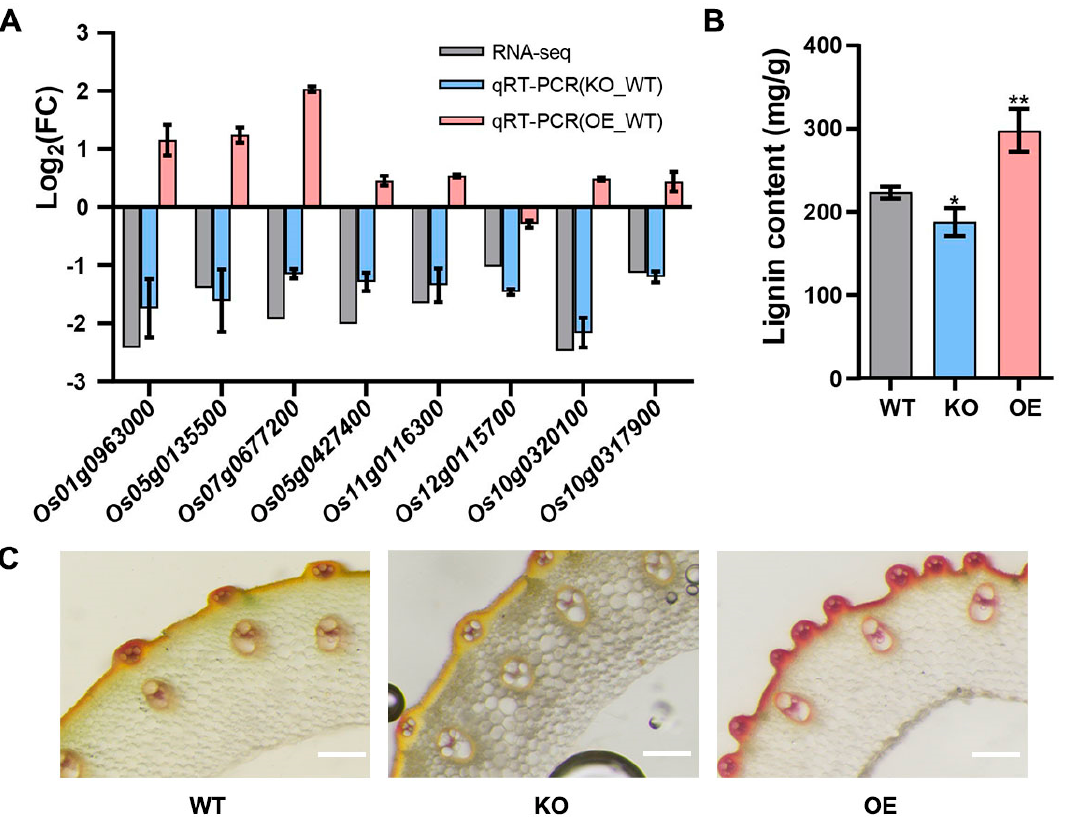
Figure 7. Detection of lignin content. ( A ) qRT − PCR of common DEGs in phenylpropane biosynthesis pathway. ( B ) Detection of lignin content. The significant differences were determined using the Student’s t − test, p < 0.05. *, p < 0.05; **, p < 0.01. ( C ) Cross − sections of the stems of WT, Osgrp3 − 27 (KO) and OE − 127 (OE), with phloroglucinol staining to detected lignin content. The scale bars indicate 200 μ m.